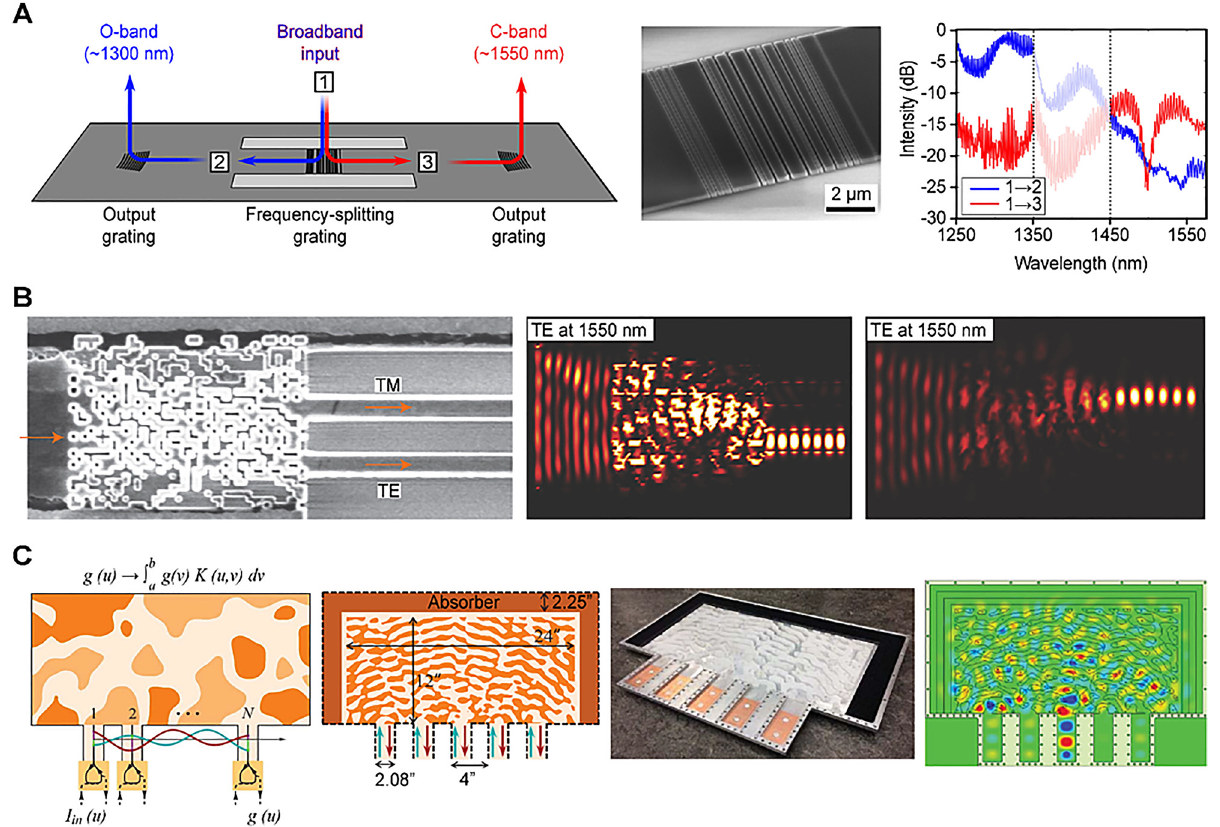
Figure 7: Inverse-designed multi-function devices. (A) Wavelength demultiplexing grating coupler. Left: schematic diagram of the designed WDM grating. Middle: SEM image of the fabricated grating. Right: Measured coupling efficiencies of the device. Reproduced with permission [152]. Copyright 2014, Nature Publishing Group. (B) Mode-converting PBS. Left: SEM image of the fabricated mode-converting PBS. Middle and Right: Simulated intensity distributions of the TE and TM modes at a wavelength of 1550 nm. Reproduced with permission [50]. Copyright 2015, Nature Publishing Group. (C) Left: Conceptual sketch of the integral solver, which is composed of an inverse-designed metamaterial kernel, N in/out coupling elements and N connecting waveguides. Left-middle: The inverse-designed distribution of the relative permittivity of the kernel. Right-middle: photograph of the constructed metamaterial kernel. Right: simulated stable electric fi eld distribution of the solver when light is excited at port 3. Reproduced with permission [36]. Copyright 2019, American Association for the Advancement of